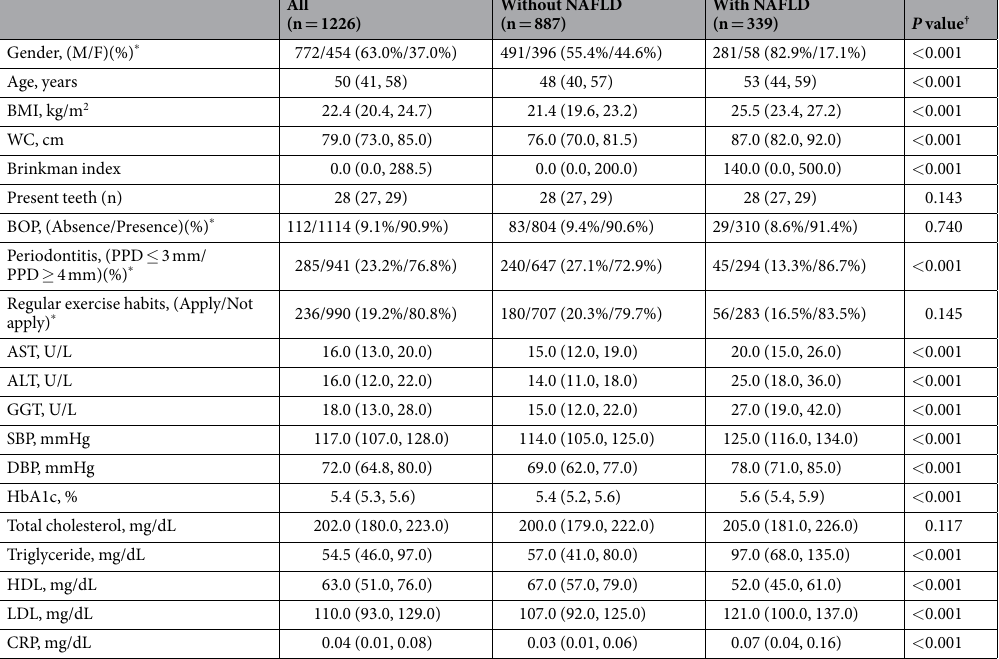
Table 1. Comparison of Characteristics between Subjects with and without NAFLD. Continuous variables are expressed as median (first quartile, third quartile) deviation. * n (%); † Chi-square test (Direct method